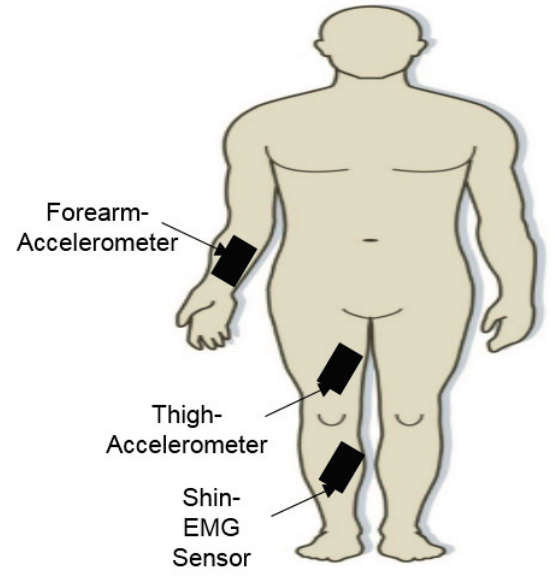
Figure 4. Placement of accelerometer sensors and surface EMG sensor on the subject (adapted from